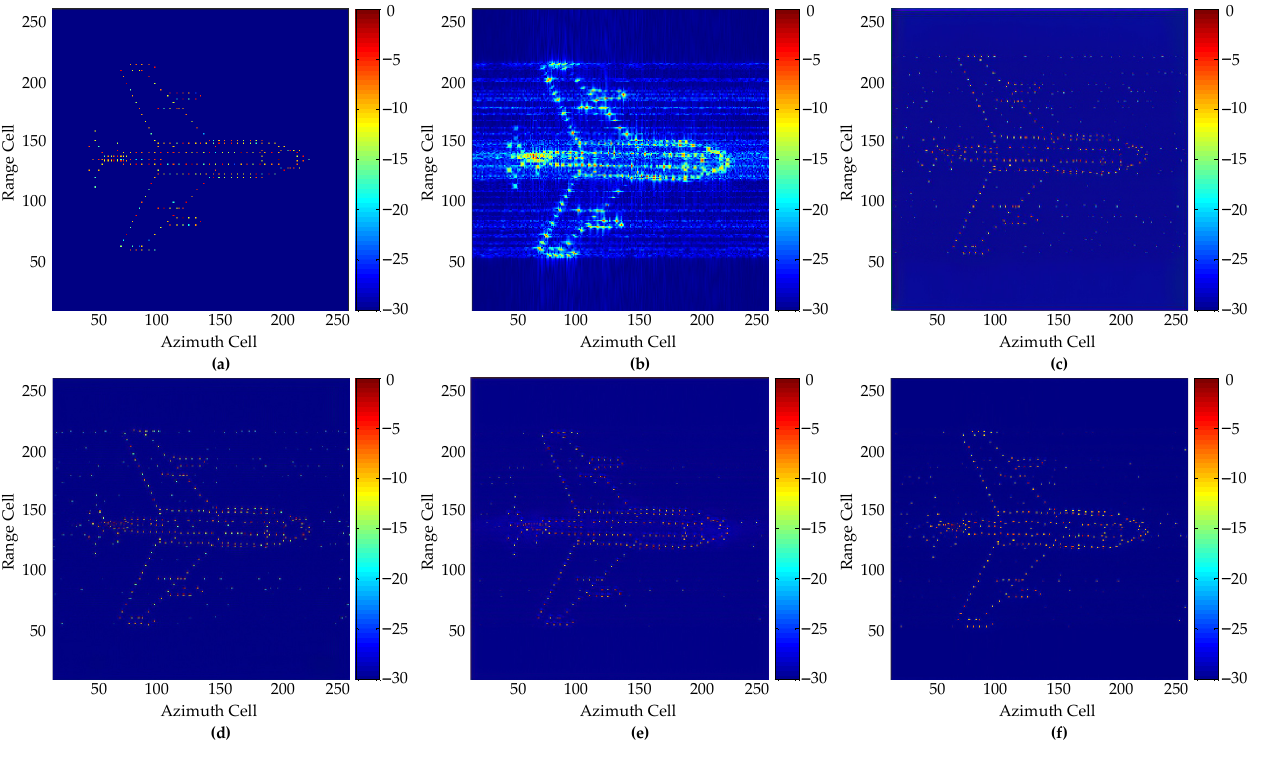
Figure 11. Imaging results of simulated aircraft under sparse aperture: ( a ) Ground truth; ( b ) IFFT;